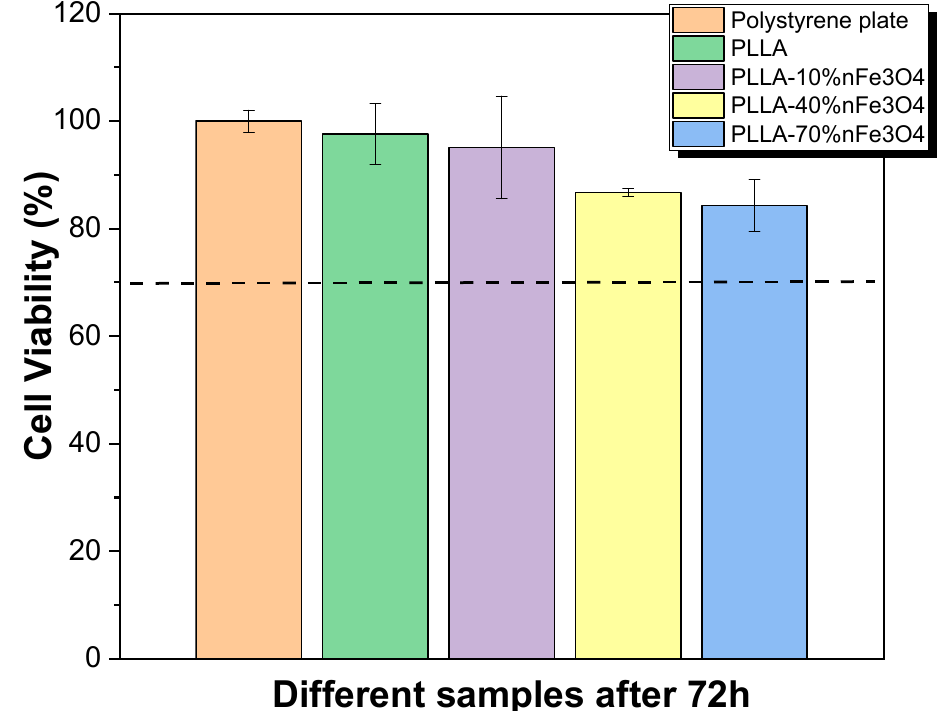
Figure 1. Cell viability of MC3T3-E1 pre-osteoblast cells after 72 h in contact with conditioned media that has been exposed to the different samples during 24 h. The imaginary line is the limit to cell viability after 72 h.